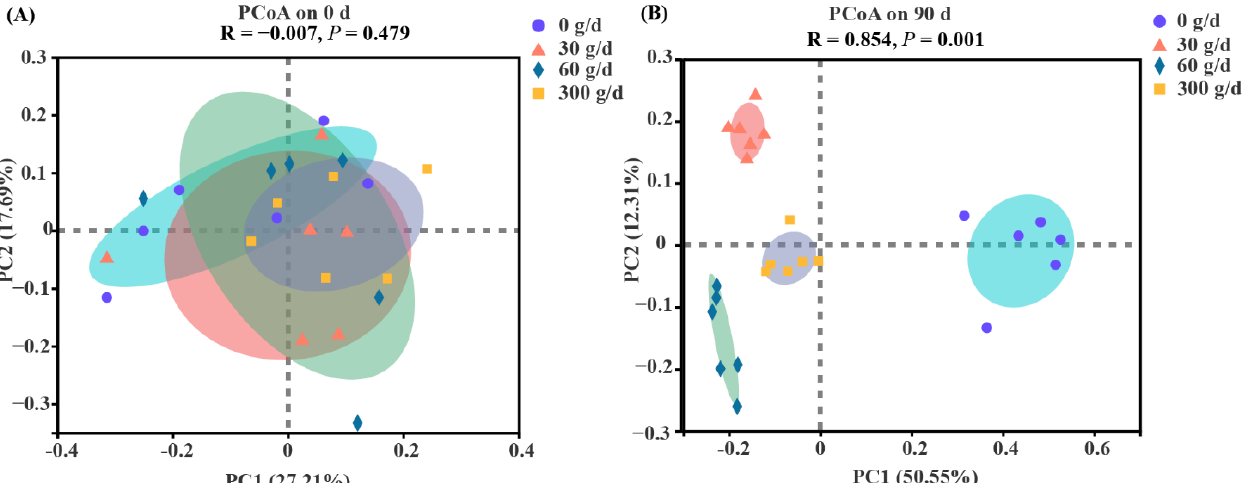
Figure 3. OTU number and alpha diversity responses of the ruminal microbiota to Acremonium ter- ricola culture supplementation in lactating dairy cows. ( A – F ) Venn diagrams showing the number of OTUs in the 0 g/d ( A ), 30 g/d ( B ), 60 g/d ( C ), and 300 g/d ( D ) groups at day 0 ( E ) and day 90 ( F );